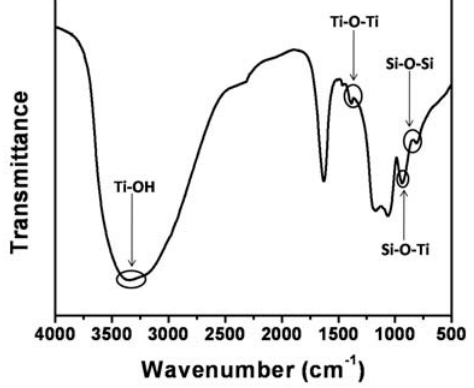
-TiO thin film with a ratio of Ti/Si = 2 2